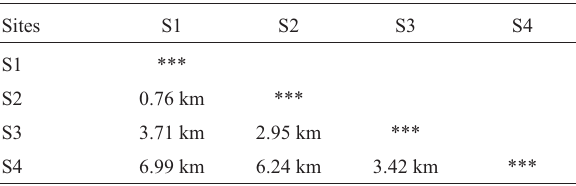
Table 1 - Geographic distances between the four sampling sites (S1, S2, S3 and